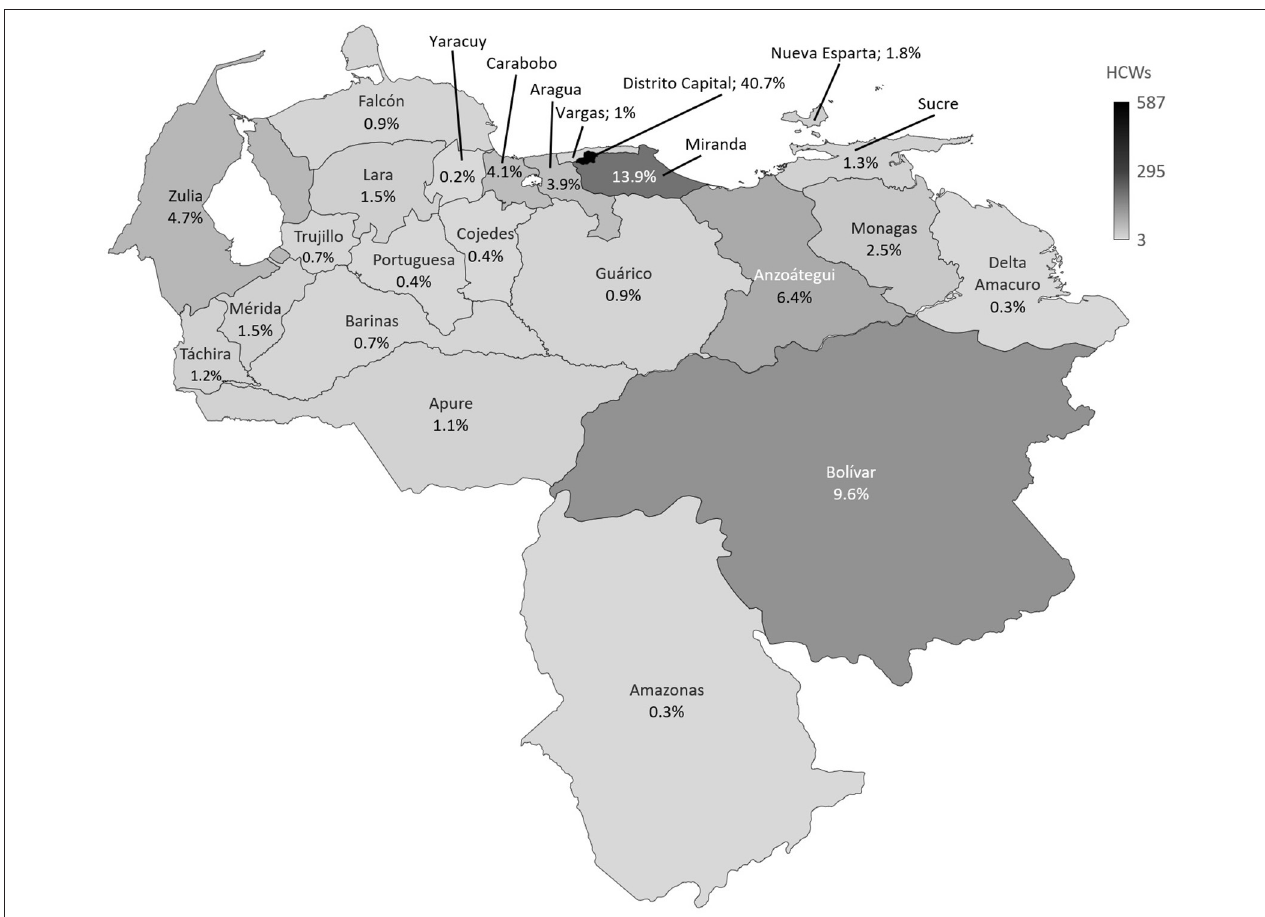
FIGURE 1 | Healthcare workers from the 24 states of Venezuela that responded to the survey. Number of healthcare workers surveyed is represented in gray scale. Frequency of healthcare workers surveyed is represented in percentage within each state. Map was performed using Microsoft ® Excel ® version 2019 (Microsoft, Redmond, WA, United